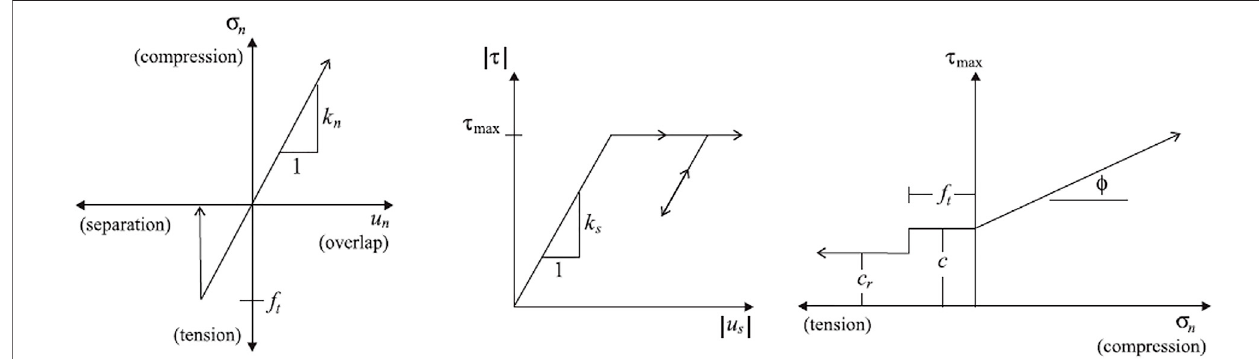
FIGURE 4 | Normal- and shear-directional interface behavior of liner elements.